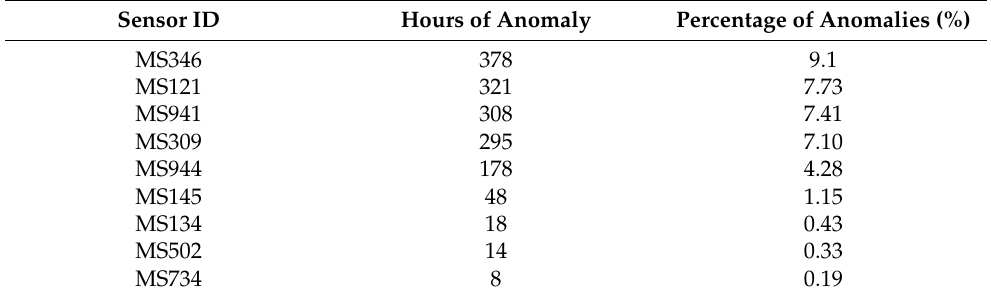
Table 3. Traffic sensors with less than 10% detected anomalies using the flow-speed correlation